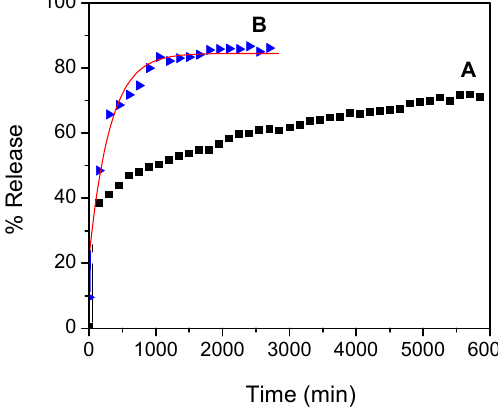
Figure 6. Release profiles of prindopril erbumine (PE) from the iron oxide nanoparticles coated with chitosan-prindopril erbumine (FCPE) into phosphate buffered solution at pH 7.4 ( A ) and pH 4.8 ( B ).